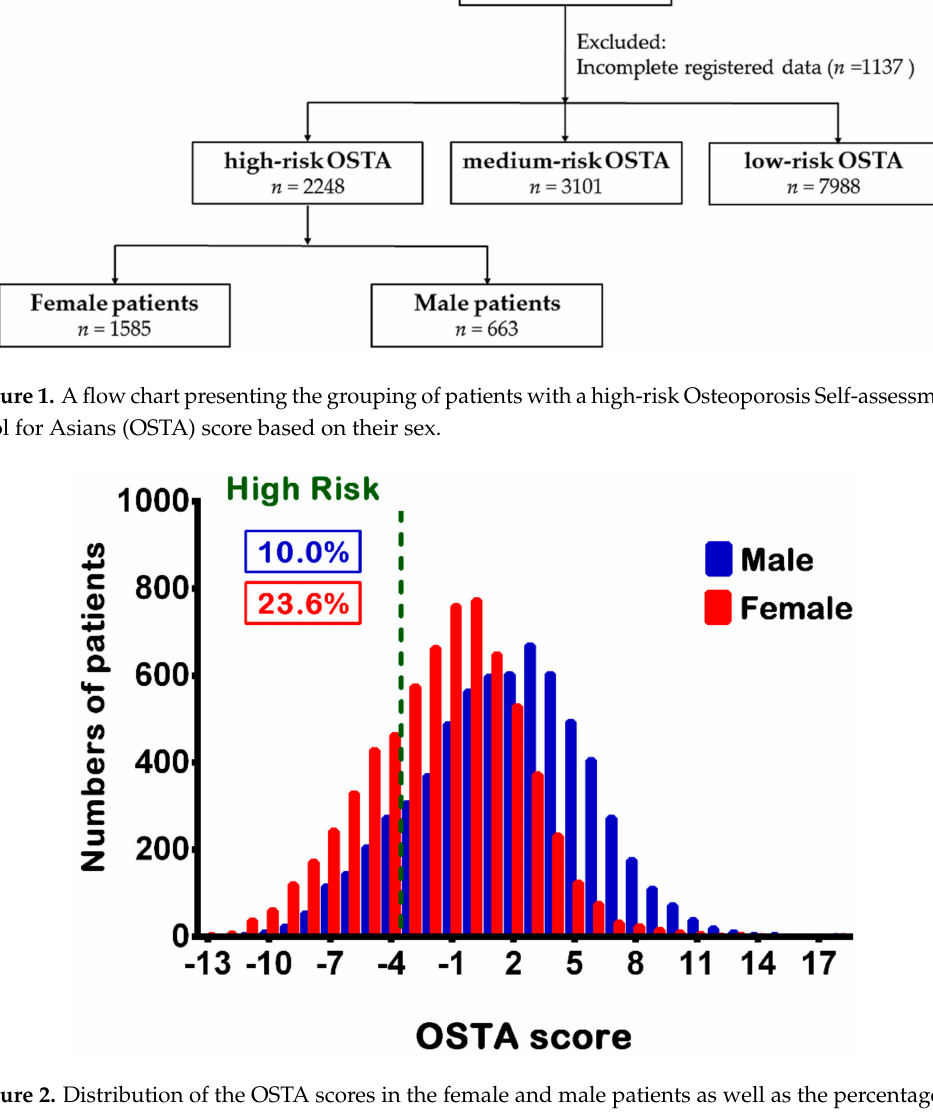
Figure 2. Distribution of the OSTA scores in the female and male patients as well as the percentage of patients having a high-risk OSTA